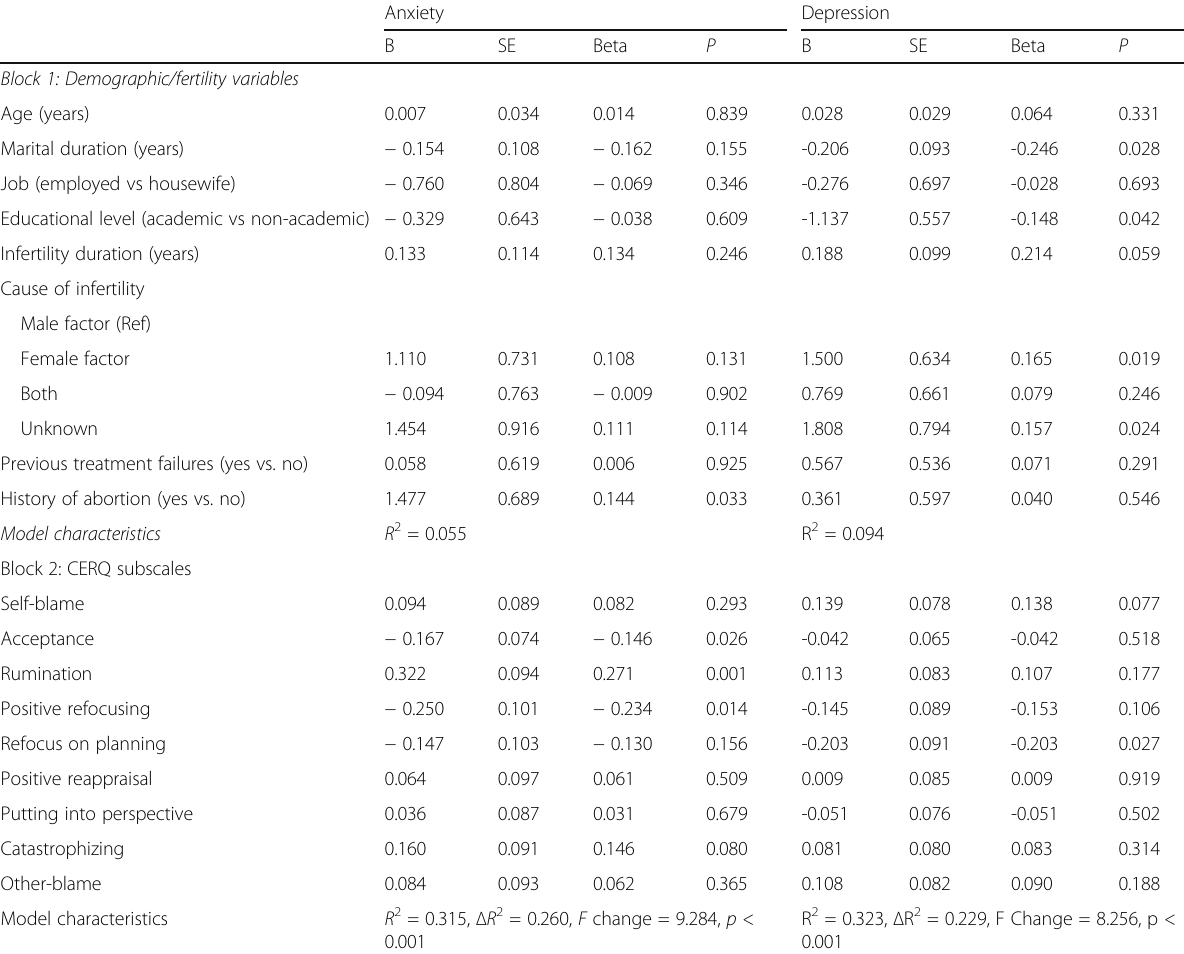
Table 3 Results of hierarchical multiple linear regressions, including factors related to anxiety and depression Anxiety